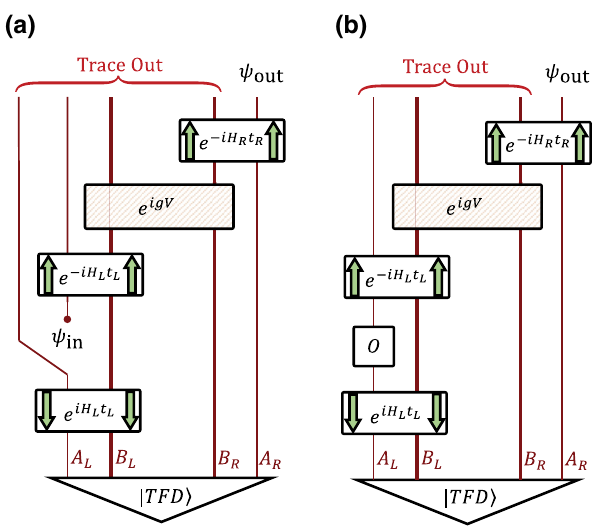
FIG. 1. The circuits considered in this paper, with H L = H T Downward arrows indicate acting with the inverse of the time- evolution operator. In both protocols, the goal is to transmit information from the left to the right. (a) The state-transfer proto- col calls for us to discard the left message qubits ( A L ) and replace them with our message (cid:3) in . The output state on the right then defines a channel applied to the input state. (b) The operator- transfer protocol calls for the operator O to be applied to A L . Based on the choice of operator, the output state on the right is modified, similar to a perturbation-response